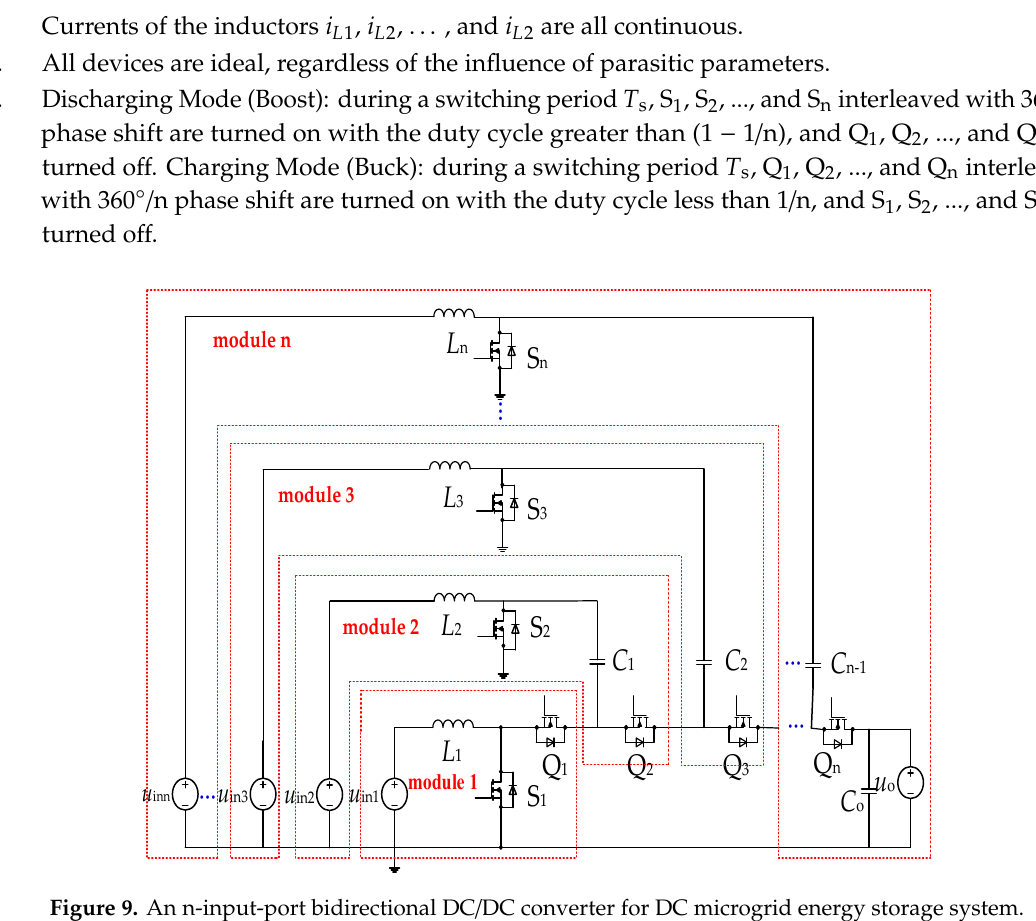
Figure 9. An n-input-port bidirectional DC/DC converter for DC microgrid energy storage system.